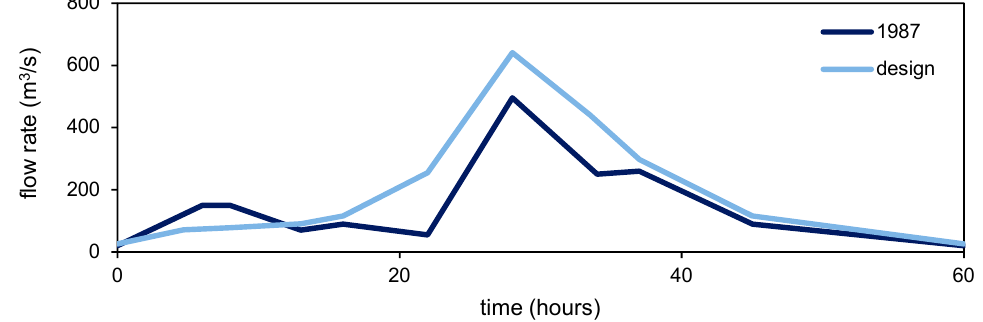
Figure 10. Flow hydrographs for the 1987 flood event and the design event.